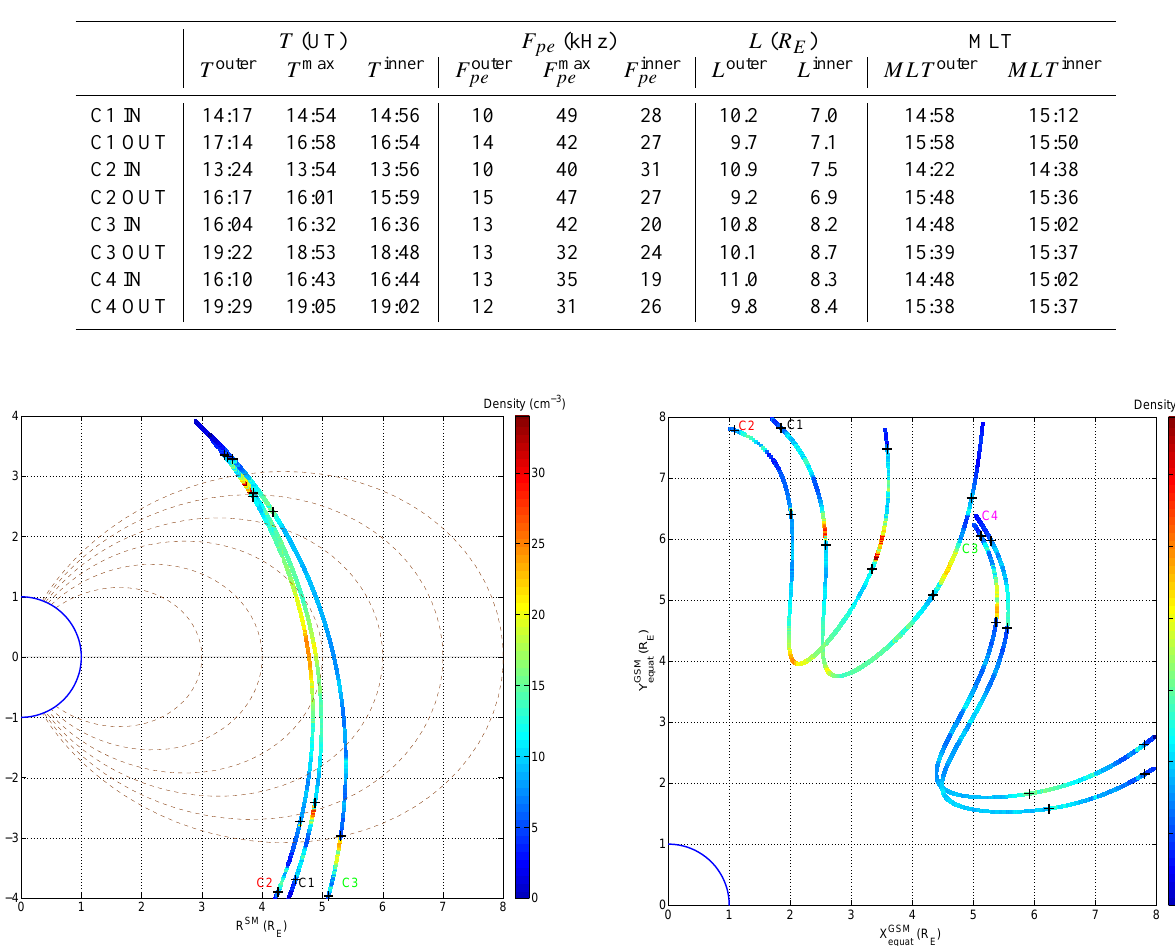
Table 1. Characteristics of the plume crossings by Cluster on 18 July 2005. The times of the outer and inner boundaries of each plume crossing are given, as well as the time of the maximum electron plasma frequency value. The plasma frequencies are given for each of those times. The L and MLT for the inner and outer boundaries are also given.